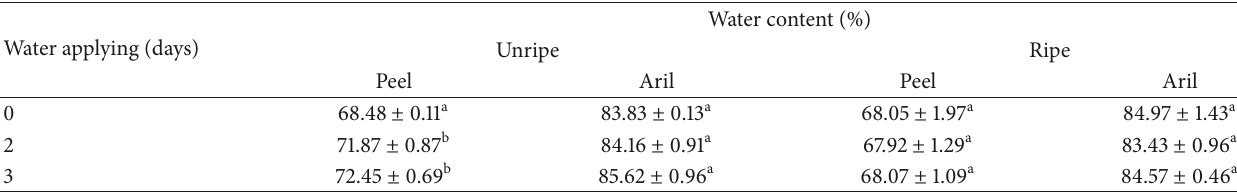
Table 1: Water content in peel and aril after water applying at fruit surface of on-tree mature green mangosteen fruit. The values were mean ± SE ( 𝑛 = 4 ). Different letters in each column showed dissimilarity from Tukey’s (HSD) test ( 𝑃 < 0.05 ). Water applying (days)